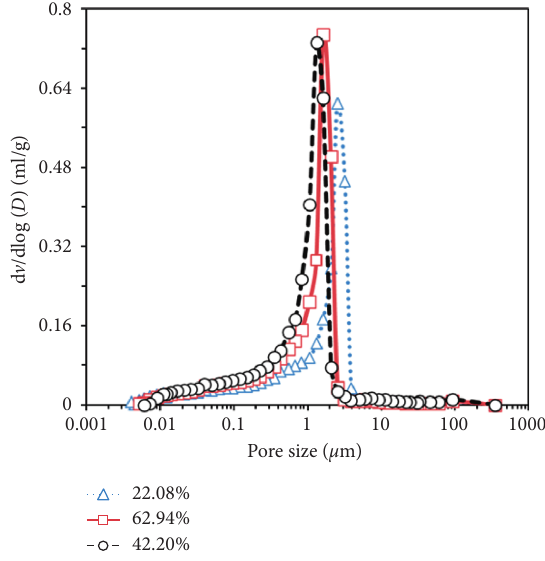
Figure 12: MIP test results under different fine